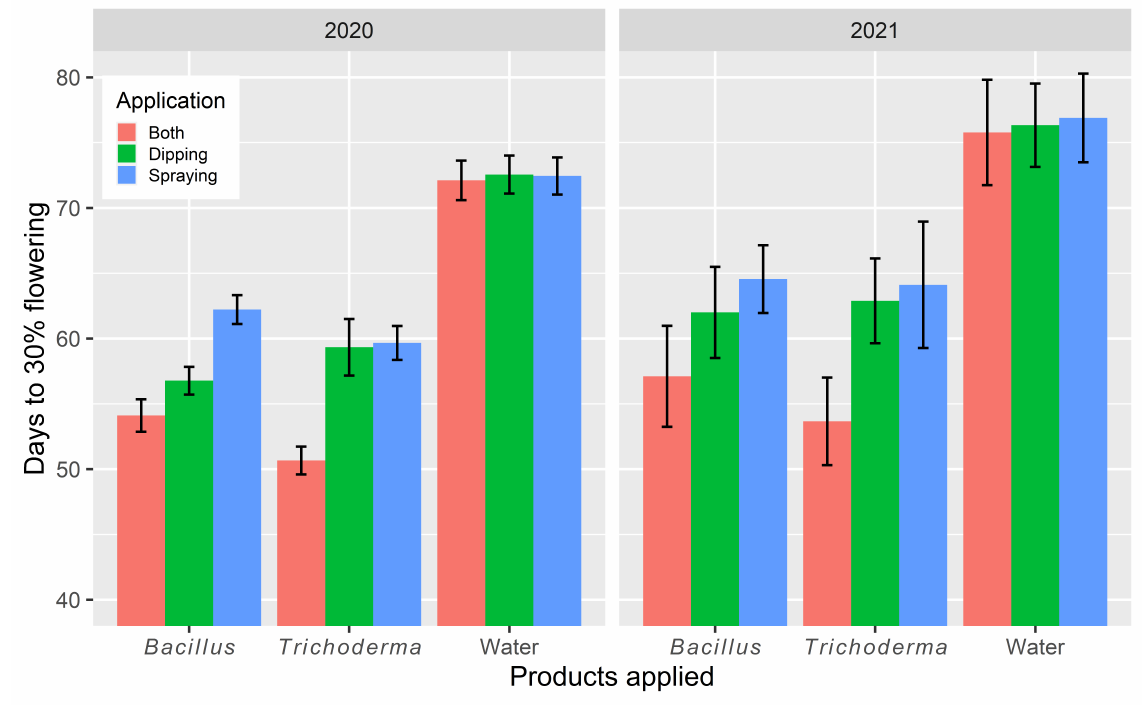
Figure 7. Time (days) to 30% flowering in each plot of rice plants that had received water or one of the two biopesticides at different times (dipping at transplanting, foliar spraying post-transplanting, or at both times) at three sites in 2020 and 2021 in Tanzania. The bar represents one standard